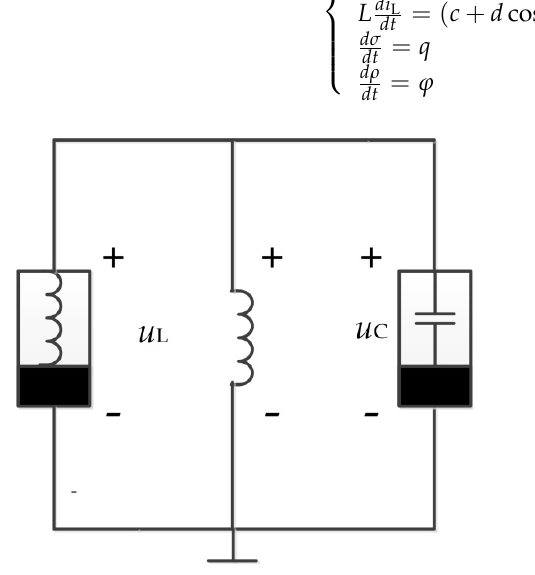
Figure 3. A novel chaotic circuit.